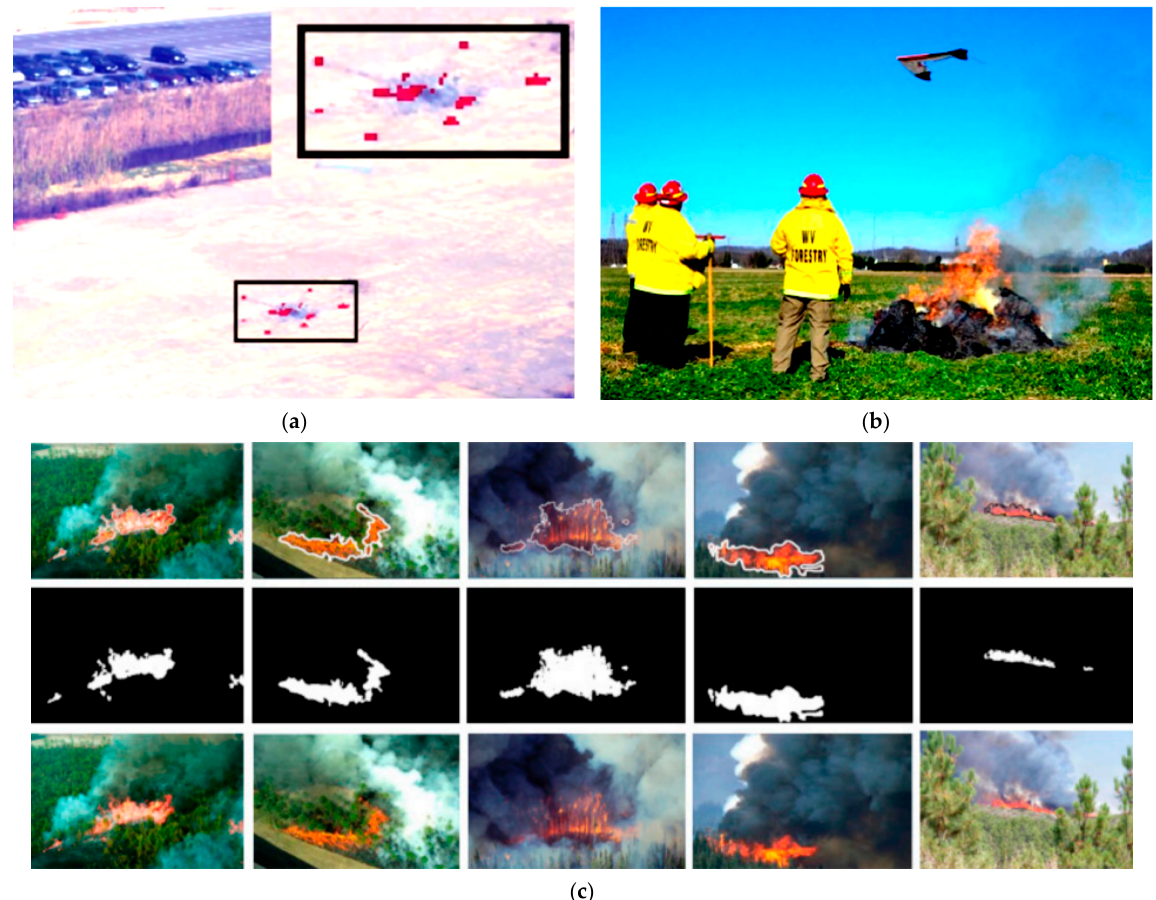
Figure 8. ( a ) Hot-spot detection and identification using image fusion (Figure from [117]), ( b ) Views of flight mission in burning area (Figure from [10]), and ( c ) Forest fire detections from aerial perspective (Figure from [124]). Table 4. Ikhana (and its predecessor, Altair) during the 2006–2009 fi re seasons [121].